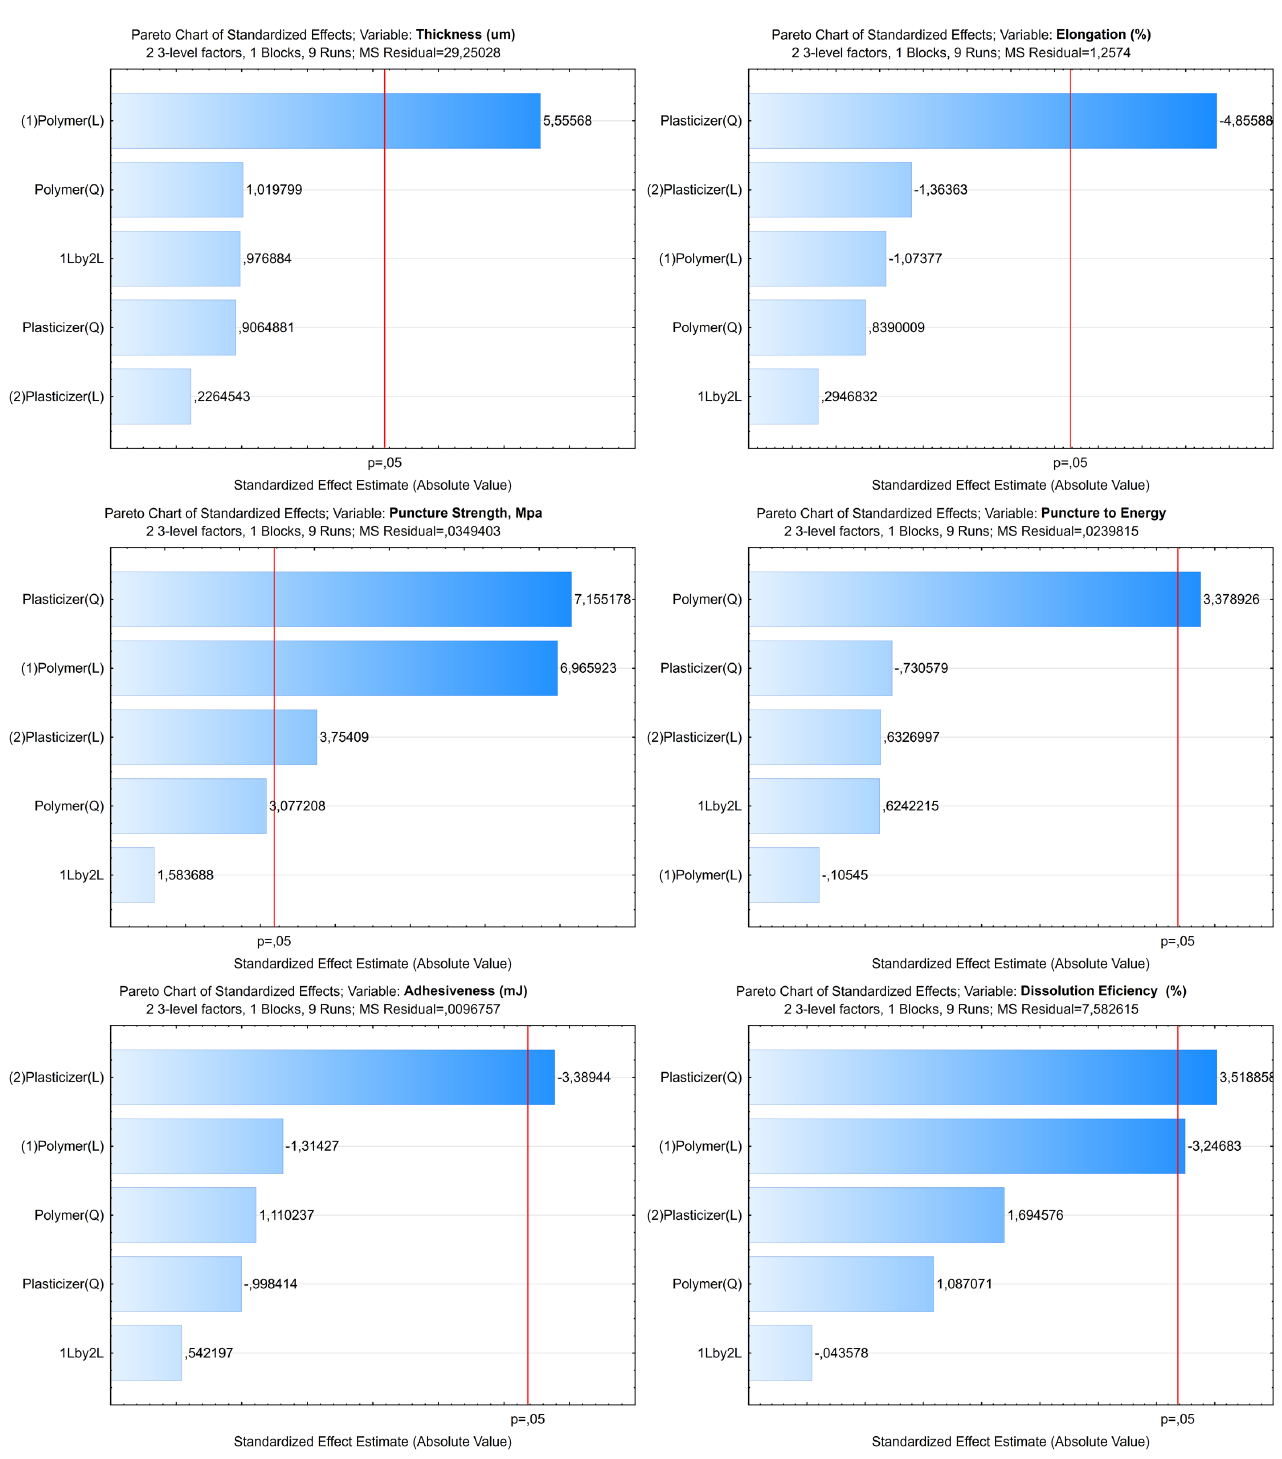
FIGURE 3 - Pareto chart of the main effects of variables (polymers and plasticizers) on the investigated